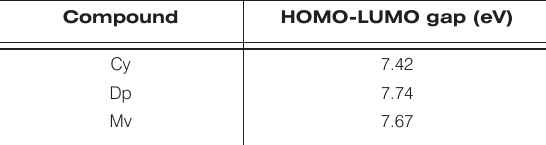
Table 4. H OMO-LUMO gap (HF/6-31+G(2d,p) level).